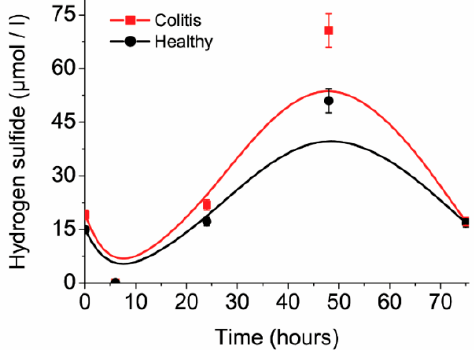
Figure 4. Amount of hydrogen sulfide in cultivation medium in 72 h.